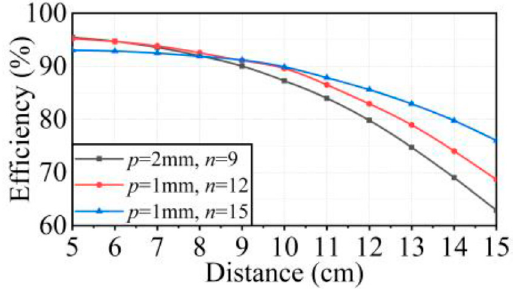
Figure 10. PTE curves with different coil parameters.